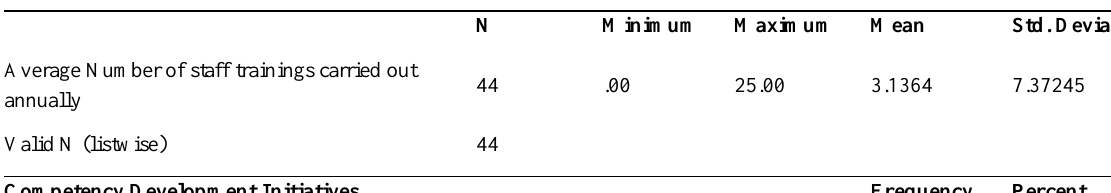
Table 7: Number of staffs training and Competency Development